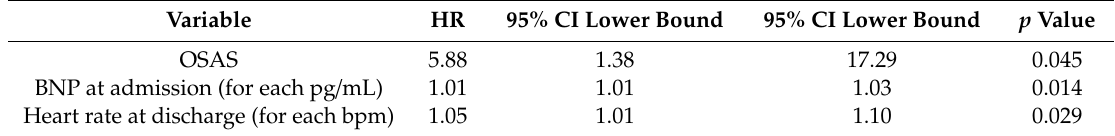
Table 3. Multivariable Cox-proportional hazard model for tachycardiomyopathy recurrence. Variable HR 95% CI Lower Bound